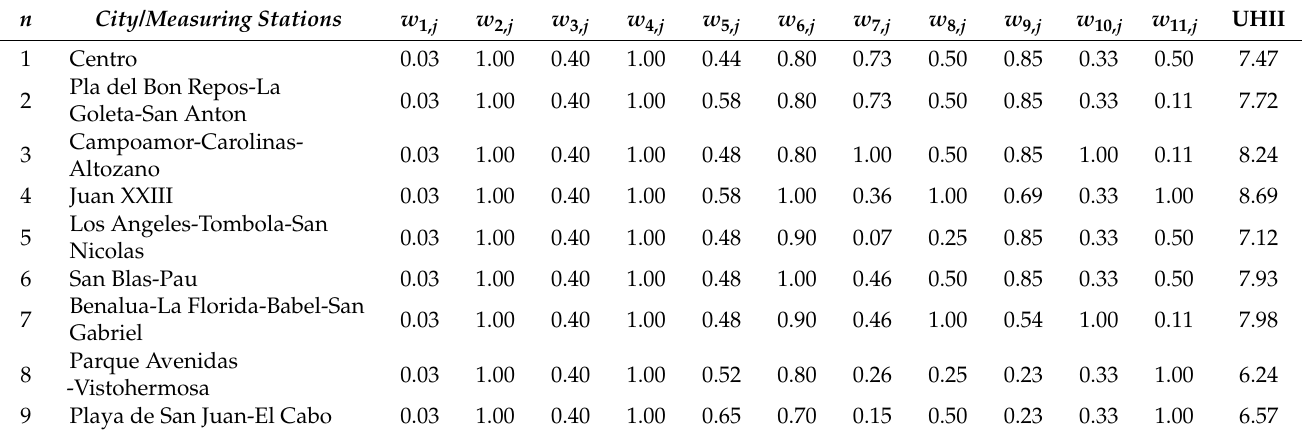
Table 5. Values of w ij weights and UHII per Alicante’s districts according to